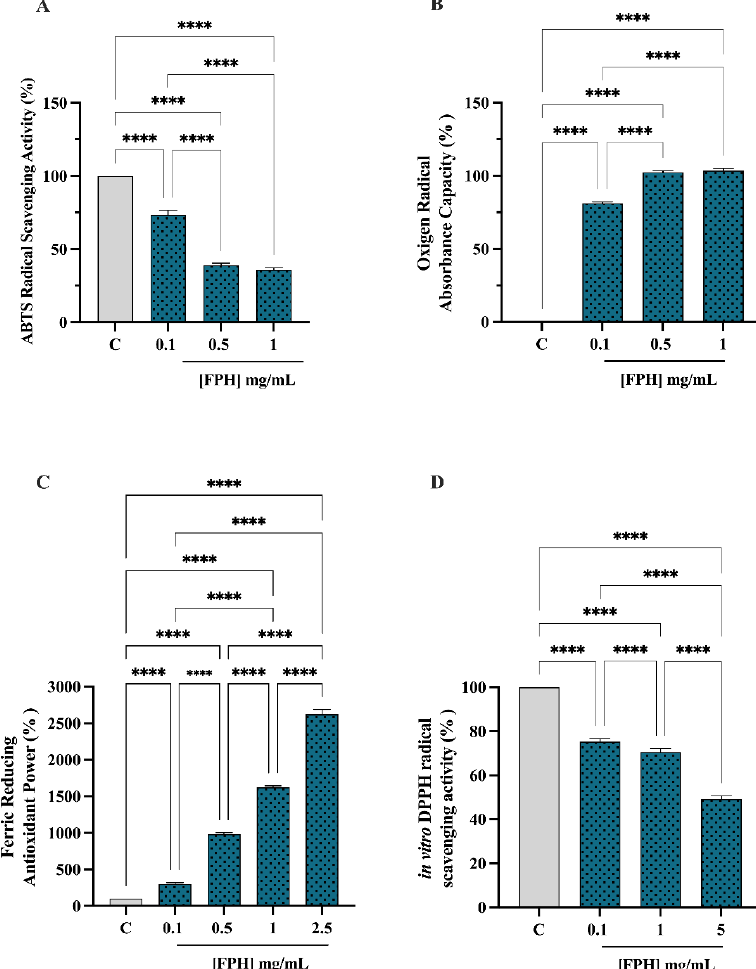
Figure 1. In vitro antioxidant power evaluation of the FPH by 2,2-azino-bis-(3-ethylbenzothiazoline- 6-sulfonic acid (ABTS) ( A ), Oxygen Radical Absorbance Capacity (ORAC) ( B ), ferric reducing anti- oxidant power (FRAP) ( C ), and 2,2-diphenyl-1-picrylhydrazyl (DPPH) ( D ) assays. The data points represent the averages ± SD of three independent experiments performed in triplicate. All data sets were analyzed by one-way ANOVA followed by Tukey’s post-hoc test. C: control sample (H 2 O), ns: not significant, (****) p < 0.0001.